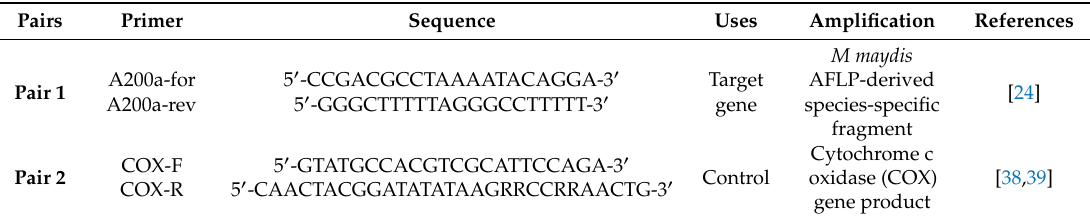
Table 1. Primers for Magnaporthiopsis maydis qPCR detection.